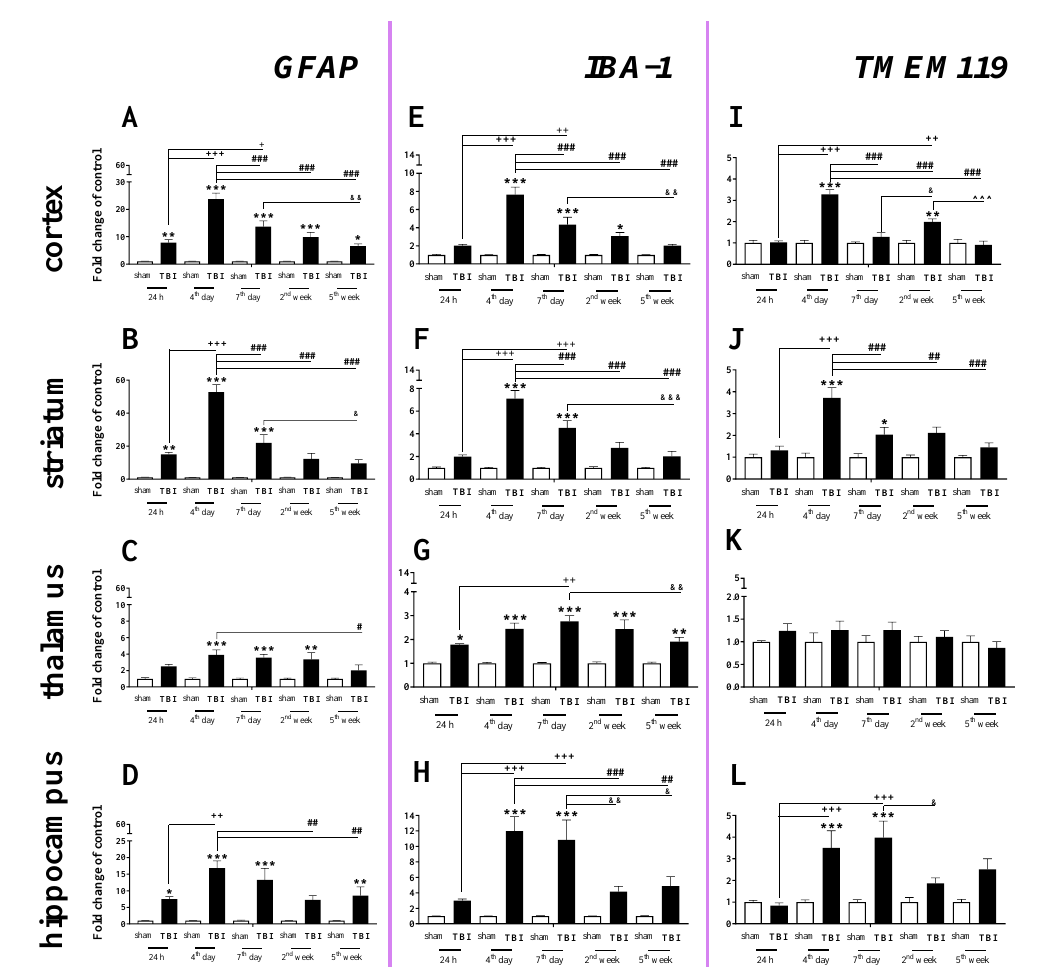
Figure 2. ( A – L ). The mRNA expression changes of GFAP, IBA-1, and TMEM119 in the cortex, striatum, thalamus, and hippocampus of TBI compared to sham-injured animals at different time points (24 h–5 weeks). The data are given as fold changes relative to the control as mean ± SEM (sham groups, n = 4–8; TBI groups, n = 5–8). * p < 0.05; ** p < 0.01; *** p < 0.001 show differences considered statistically significant between the sham and TBI groups, + p < 0.05; ++ p < 0.01; +++ p < 0.001 show differences considered statistically significant comparing to the 24 h TBI group; # p < 0.05; ## p < 0.01; ### p < 0.001 show differences considered statistically significant comparing to the 4th day TBI group; & p < 0.05; && p < 0.01; &&& p < 0.001 show differences considered statistically significant when comparing to the 7th day TBI group; ^^^ p < 0.001 shows differences considered statistically significant comparing to the 2 weeks TBI group as estimated by two-way ANOVA followed by Bonferroni’s post hoc test.